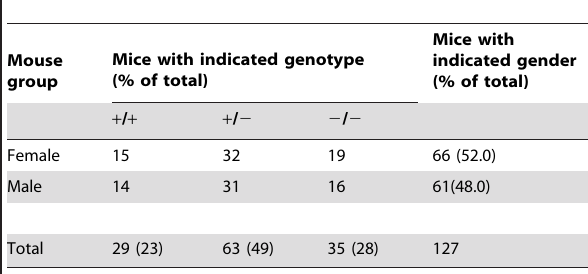
Table 1. Genotype analysis of progeny resulting from crossbreeding Decr + / 2 mice.